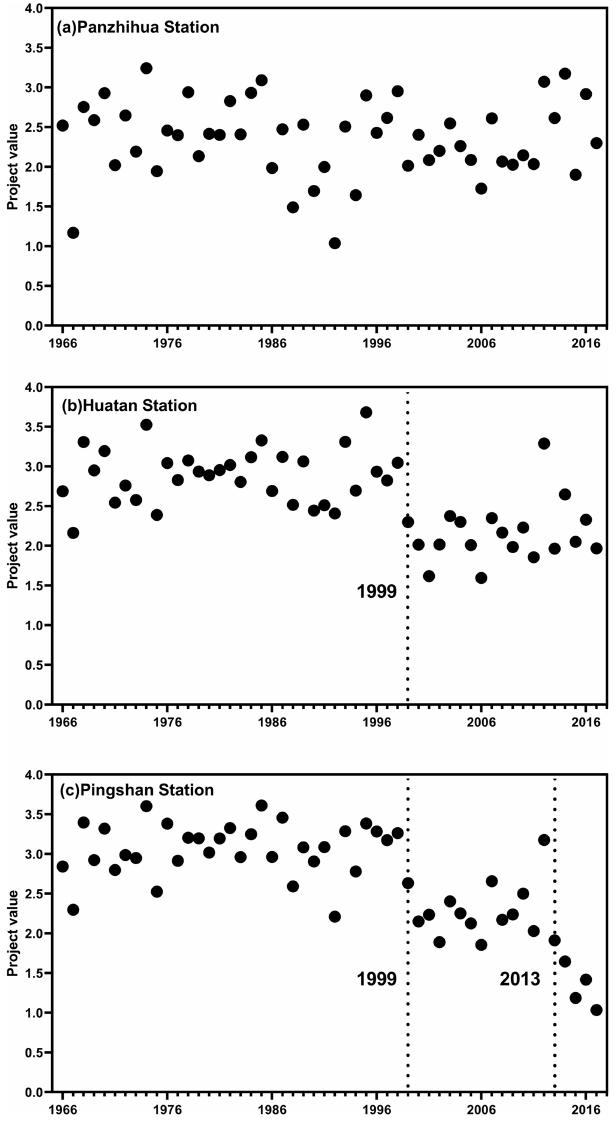
Figure 4. Project values in (a) Panzhihua Station, (b) Huatan Sta- tion and (c) Pingshan